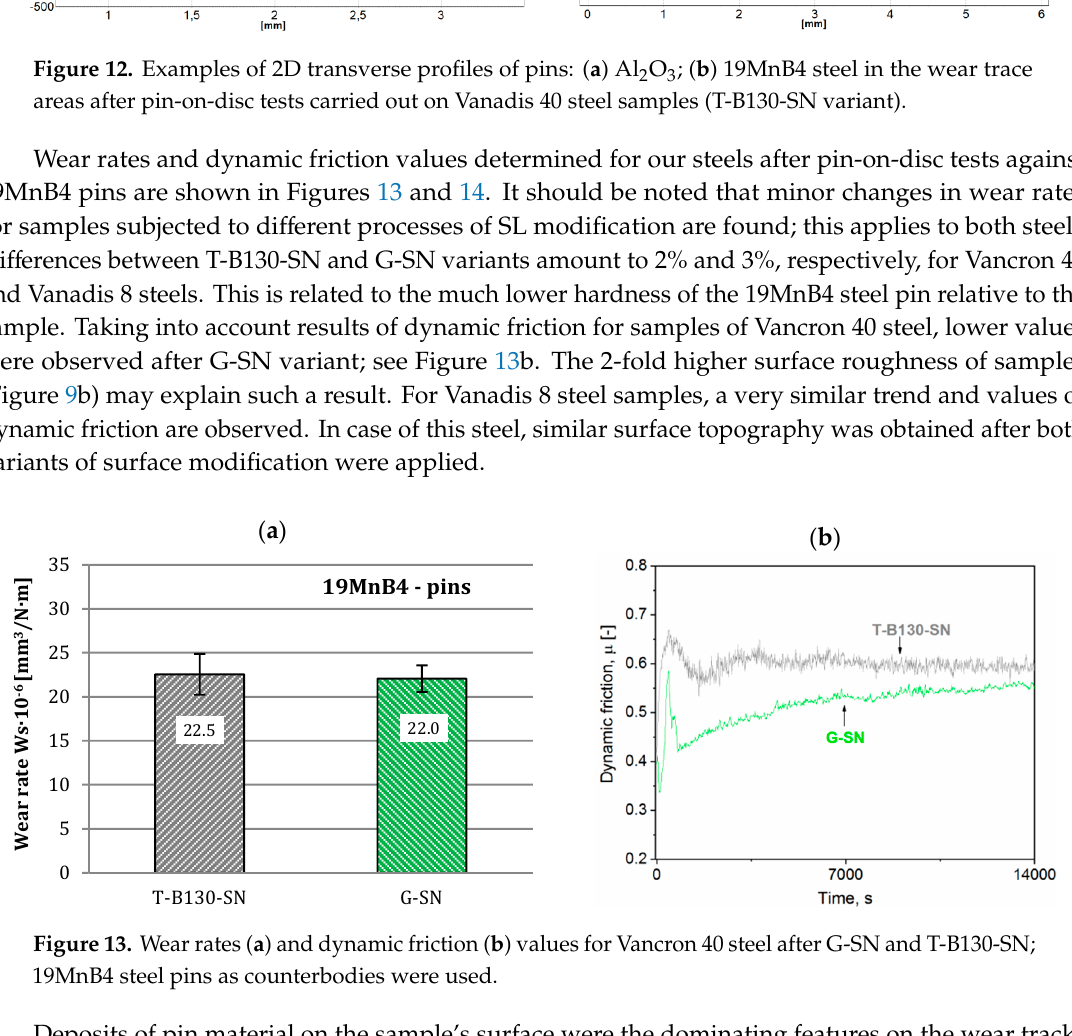
Figure 14. Wear rates ( a ) and dynamic friction ( b ) values for Vanadis 8 steel after G-SN and T-B130- SN; 19MnB4 steel pins as counterbodies were used. Deposits of pin material on the sample’s surface were the dominating features on the wear tracks created after pin-on-disc tests using 19MnB4 steel pins. Examples of SEM images of wear traces on Vanadis 8 steel samples are shown in Figure 15. Large deposits of material built up on the disc surface in the G-SN variant appeared. Only a little transfer of pin material on the sample surface was observed after three stage process. Unlubricated sliding wear tests of D2 steel (sample) and AISI 1018 steel (pin) pairs with more than a twice higher hardness of samples, carried out by Okonkwo et al. [25], indicate that the material adhesion was also the dominant mechanism for the ambient temperature wear tests. ( a )